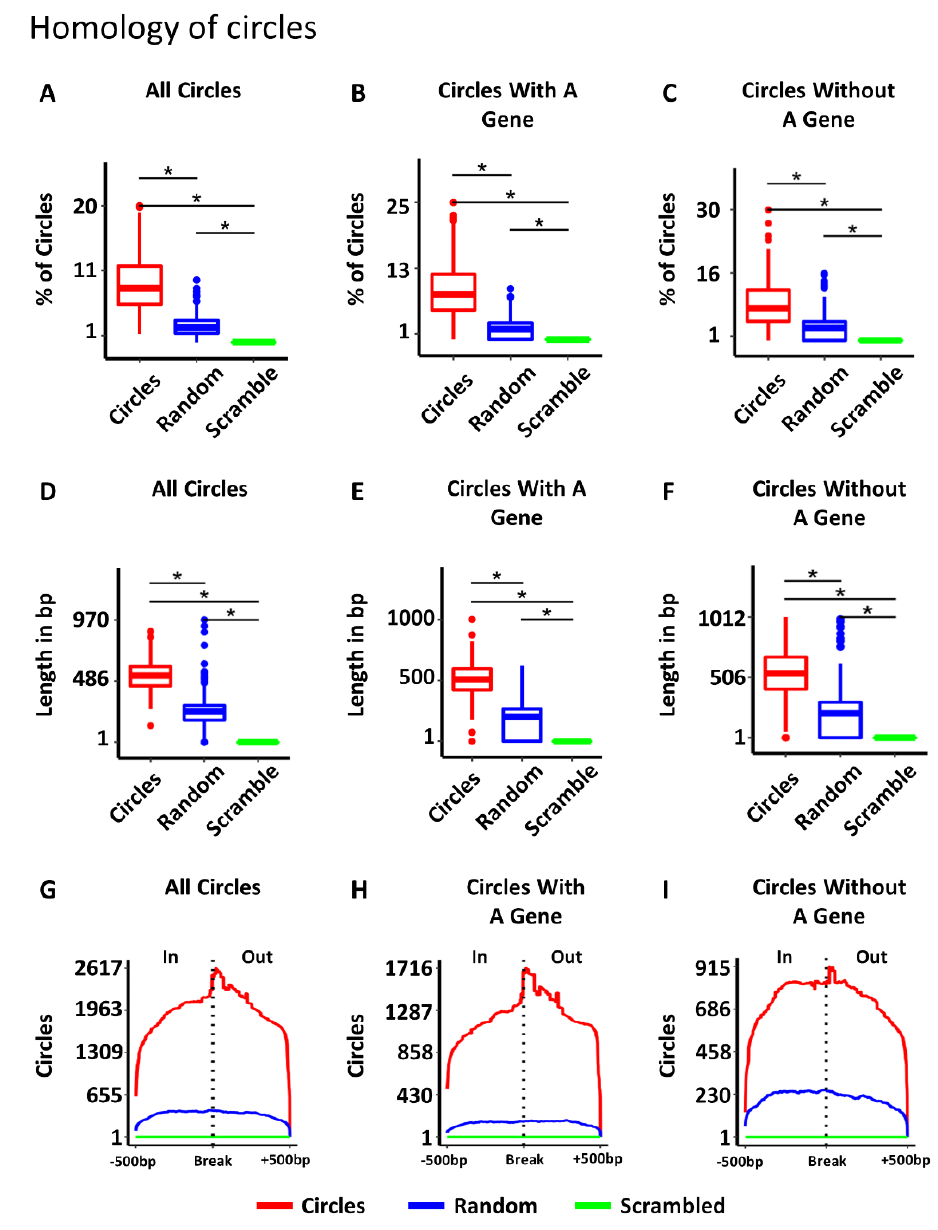
Figure 4. The breakpoints of circular DNA exhibit self-homology. ( A ) Percent of circles with self- homology compared to random and scrambled controls. ( B ) Percent of circles with genes with self-homology compared to random and scrambled controls. ( C ) Percent of circles without genes with self-homology compared to random and scrambled controls. ( D ) Length of homology in bp for circles compared to random and scrambled controls. ( E ) Length of homology in bp for circles with genes compared to random and scrambled controls. ( F ) Length of homology in bp for circles without genes compared to random and scrambled controls. ( G ) Homology is enriched near the circle breakpoint in all circles. ( H ) Homology is enriched near the circle breakpoint in circles with genes. ( I ) Homology is enriched near the circle breakpoint in circles without genes. In = region inside the circle, out = region outside the circle. Significance was determined using an ANOVA, with a post-hoc Tukey test. * indicates p -values less than